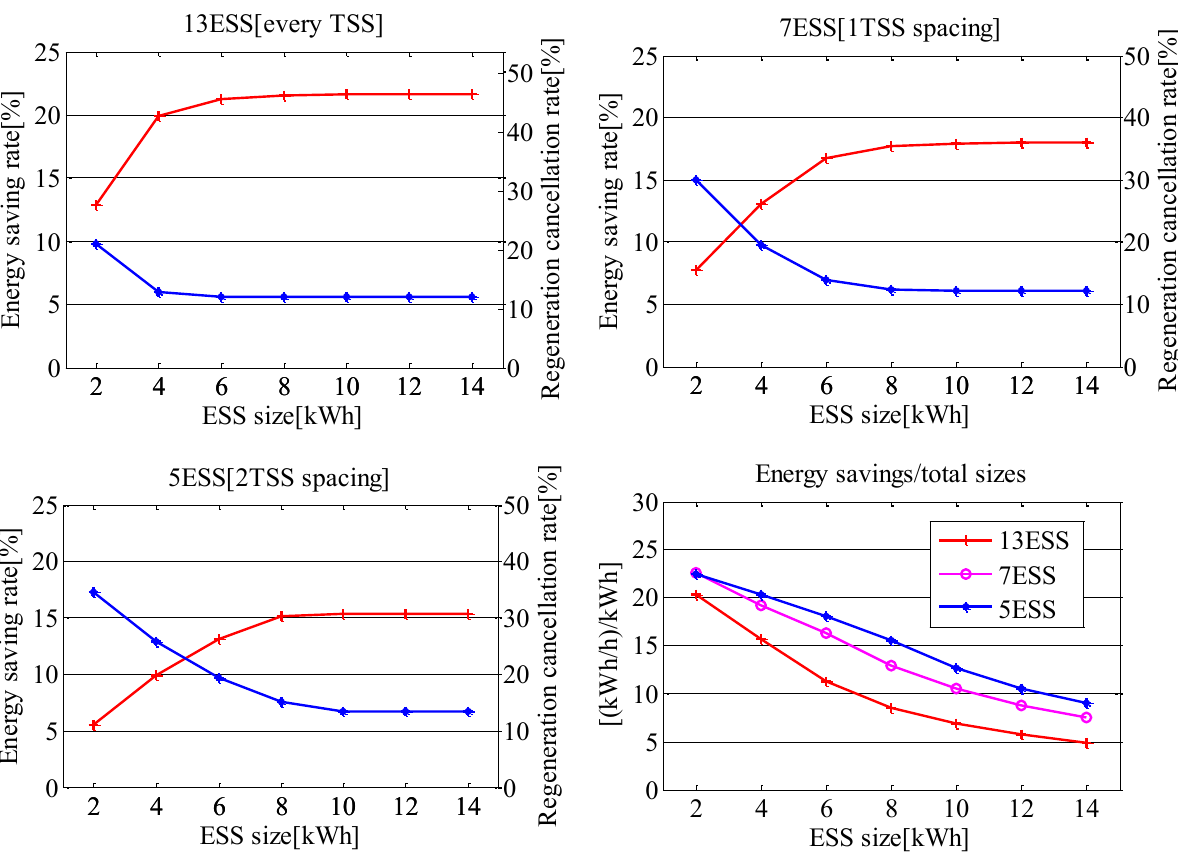
Figure 14. Energy saving rate and regeneration cancellation rate